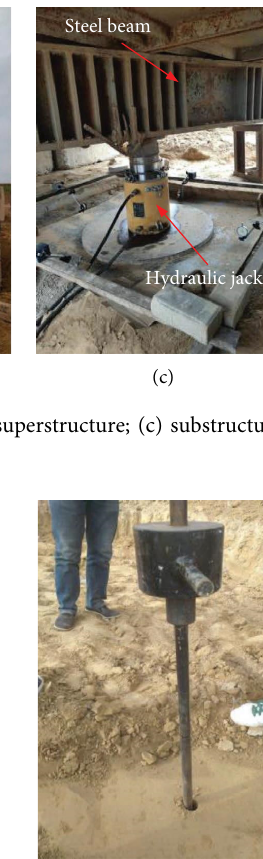
Figure 8: Heavy-duty penetration